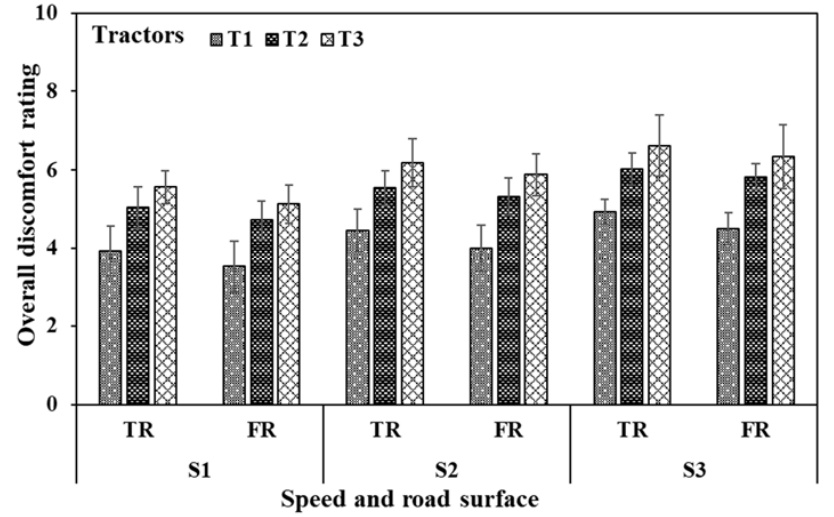
Figure 12. Overall discomfort rating of operators during the tractor clutch and brake operations. Table 4. Accuracy of operator’s overall discomfort classification using machine learning algorithms.